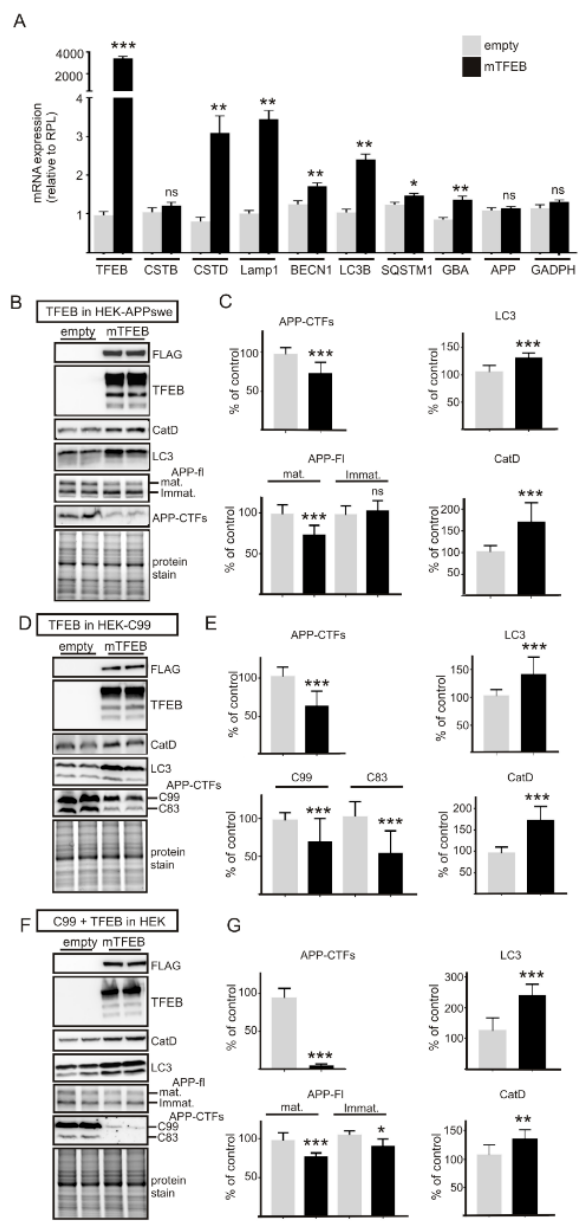
Figure 2. TFEB overexpression in HEK-293 APPswe or C99 expressing cells leads to the induction of numerous lysosomal-autophagic genes and to reduced C99 levels. ( A ) Bars show the quantification of qPCR analysis of TFEB-mediated gene transcription in naïve HEK-293-APPswe cells. ( B – G ) Immunoblot analysis of TFEB-mediated e ff ects on lysosomal activation (cathepsin D and LC3 immunoreactivities) and APP / APP-CTF levels in HEK-293 cells stably expressing APPswe ( B , C ) or C99 ( D , E ), or in naïve HEK-293 cells transiently transfected with C99 and TFEB cDNA or empty vector ( F , G ). Bars in ( C , E , G ) correspond to the quantification of APP-CTFs, APPfl, LC3 and CatD (n = 12 from at least 3 independent determinations in each cell line) and are represented as means ± SEM and are expressed as the percent of control transfected cells (taken as 100). Statistical di ff erences were * p < 0.05, ** p < 0.01, *** p < 0.001, ns = non significant ( p > 0.05), versus control (empty) cells according to the Mann–Whitney